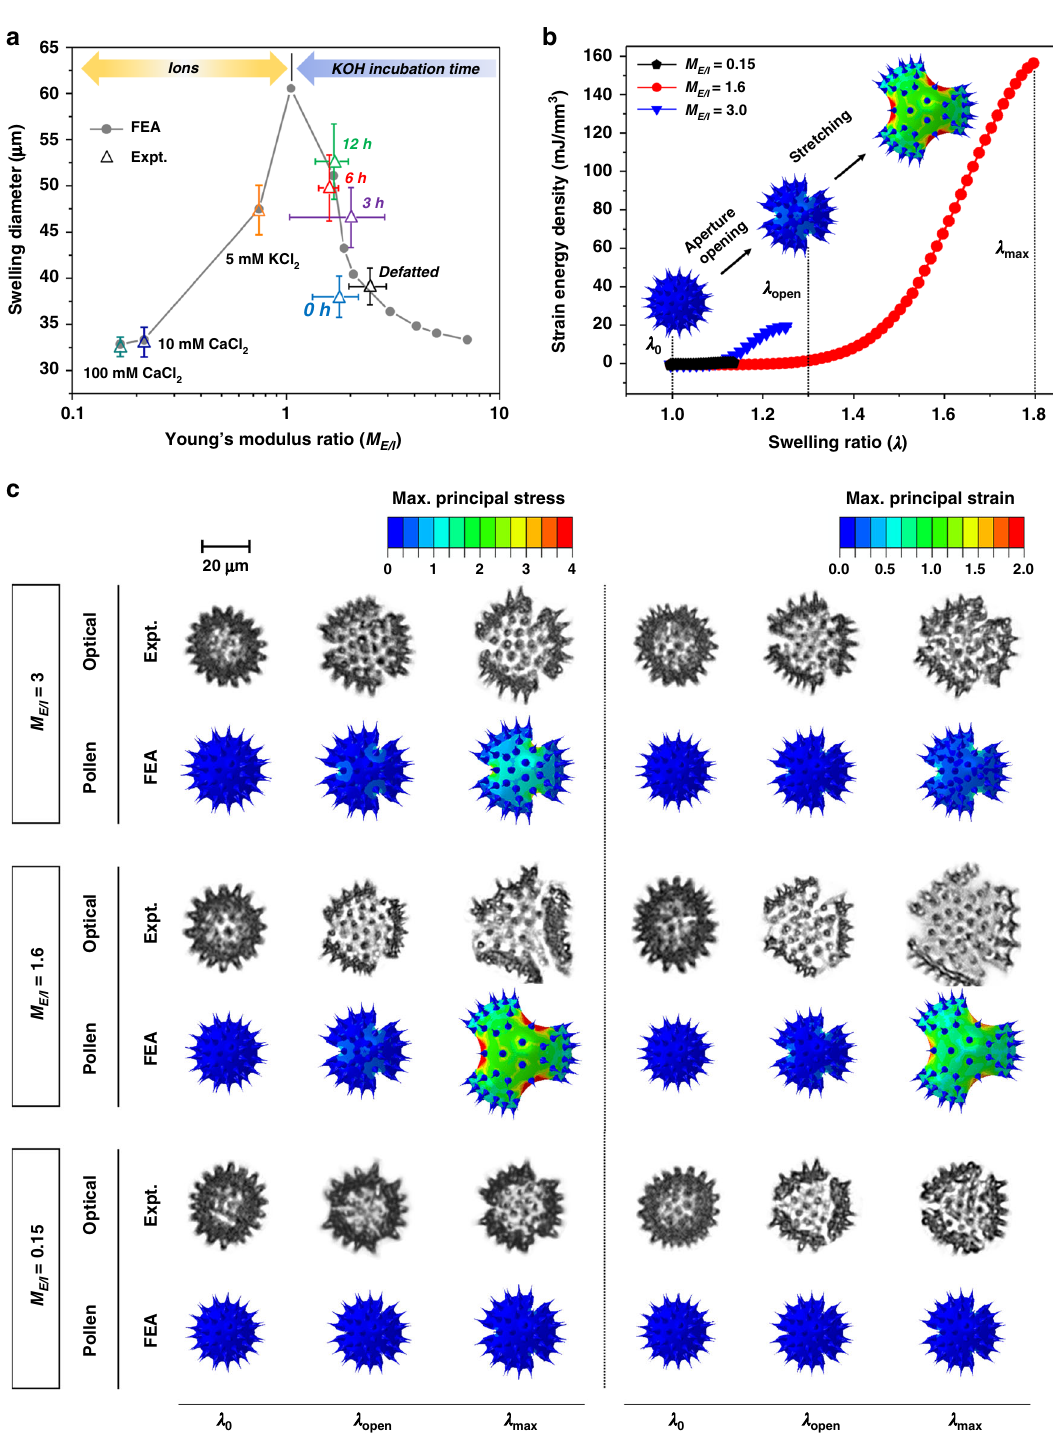
Fig. 3 Mechanical response of pollen microgel particles. a Swelling diameter of pollen microgel particle as a function of the ratio of the Young ’ s modulus values of the exine to intine layers, M E / I . b Predicted evolution of the strain energy density during pollen expansion as a function of the swelling ratio ( λ ) for three typical Young ’ s modulus ratio values ( M E / I = 0.15, 1.6, and 3). c Maximum principal stress and maximum principal strain contours of the pollen microgel particles ( M E / I = 0.15, 1.6, and 3) for three critical swelling ratios ( λ 0 , λ open , and λ max ) (labeled FEA), along with representative optical micrographs of pollen microgel particles in various chemical environments (i.e., ionic changes) that triggered similar morphological evolutions. M E / I = 0.15 corresponds to pollen microgel particles immersed in 100 mM CaCl 2 ; M E / I = 1.6 to 6 h KOH-treated pollen microgels incubated in pH 10 solution; M E / I = 3 to defatted pollen grains. Source data are provided as a Source Data fi